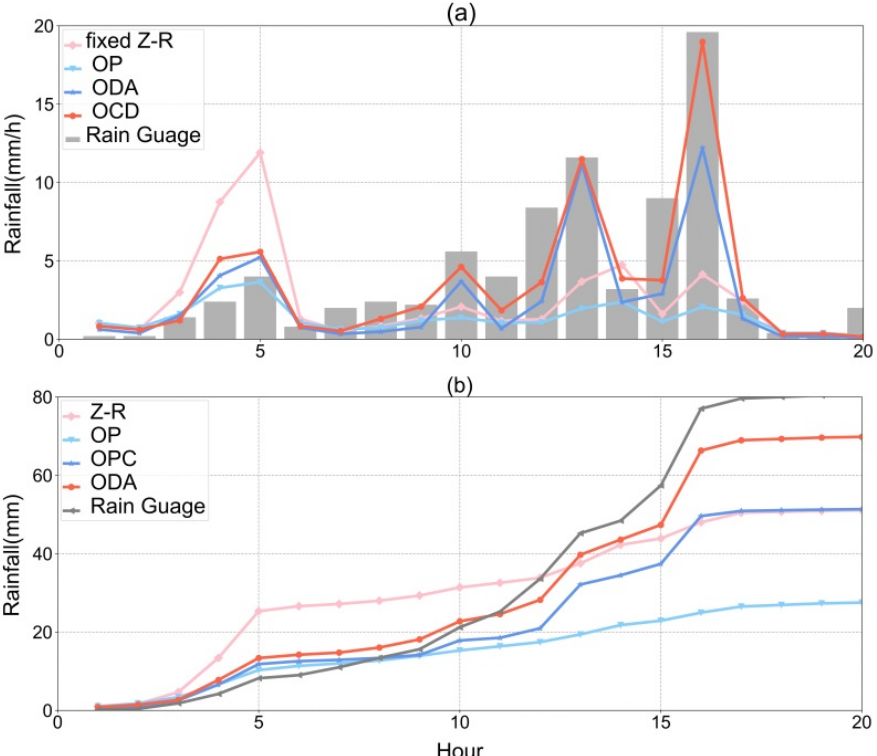
Figure 6. Time-by-time evolutionary characteristics of 4 QPE algorithms (rainfall event 5, rain gauge ID: 40505780), ( a ) hourly, ( b ) cumulant.